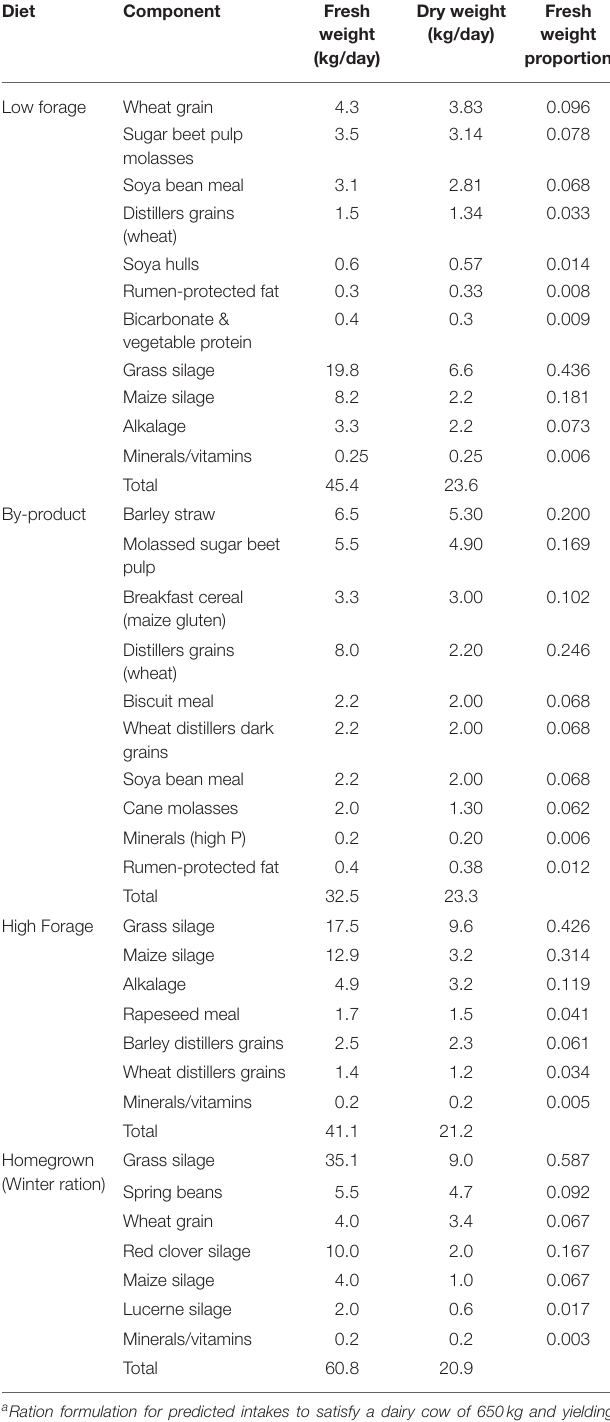
TABLE 1 | Ration constituent proportions in fresh weight and dry weight a .